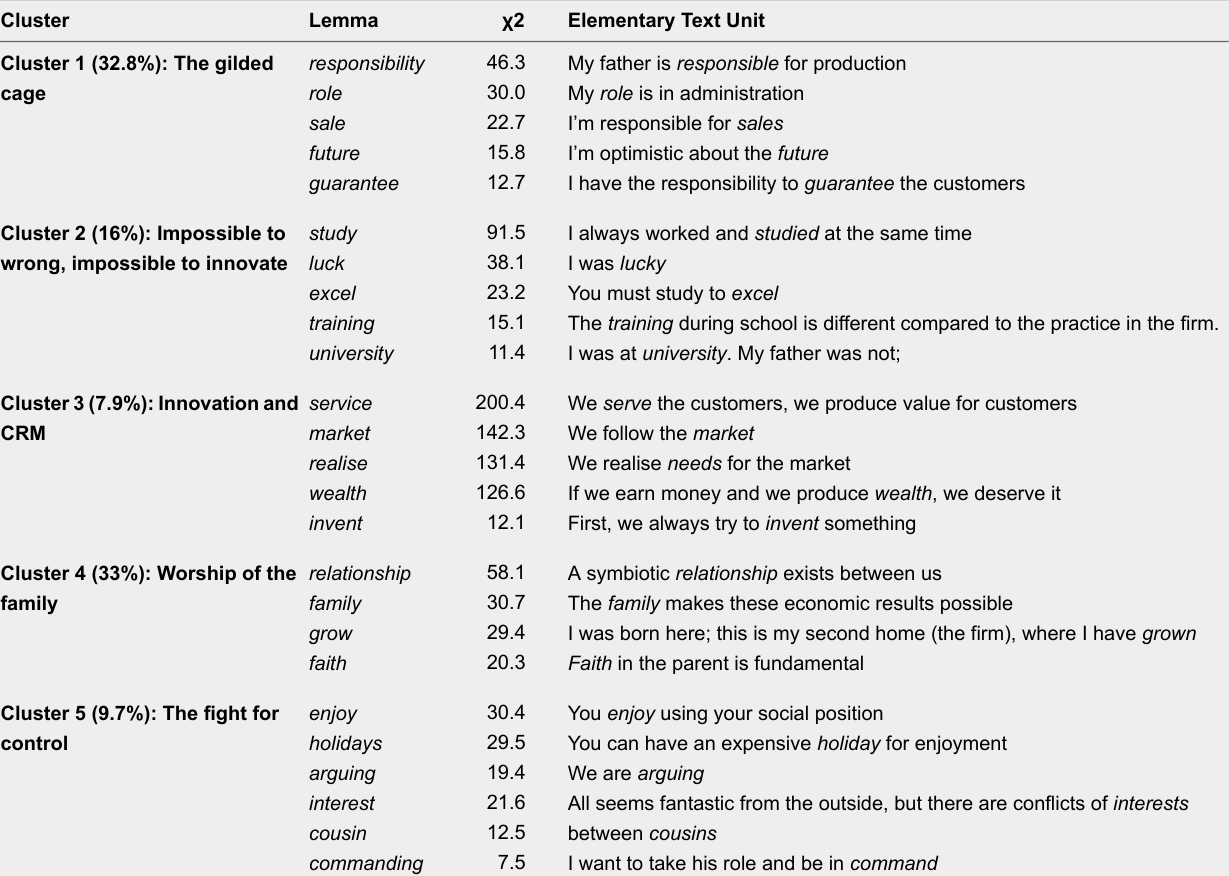
The Most Representative Lemmas and the Elementary Text Unit